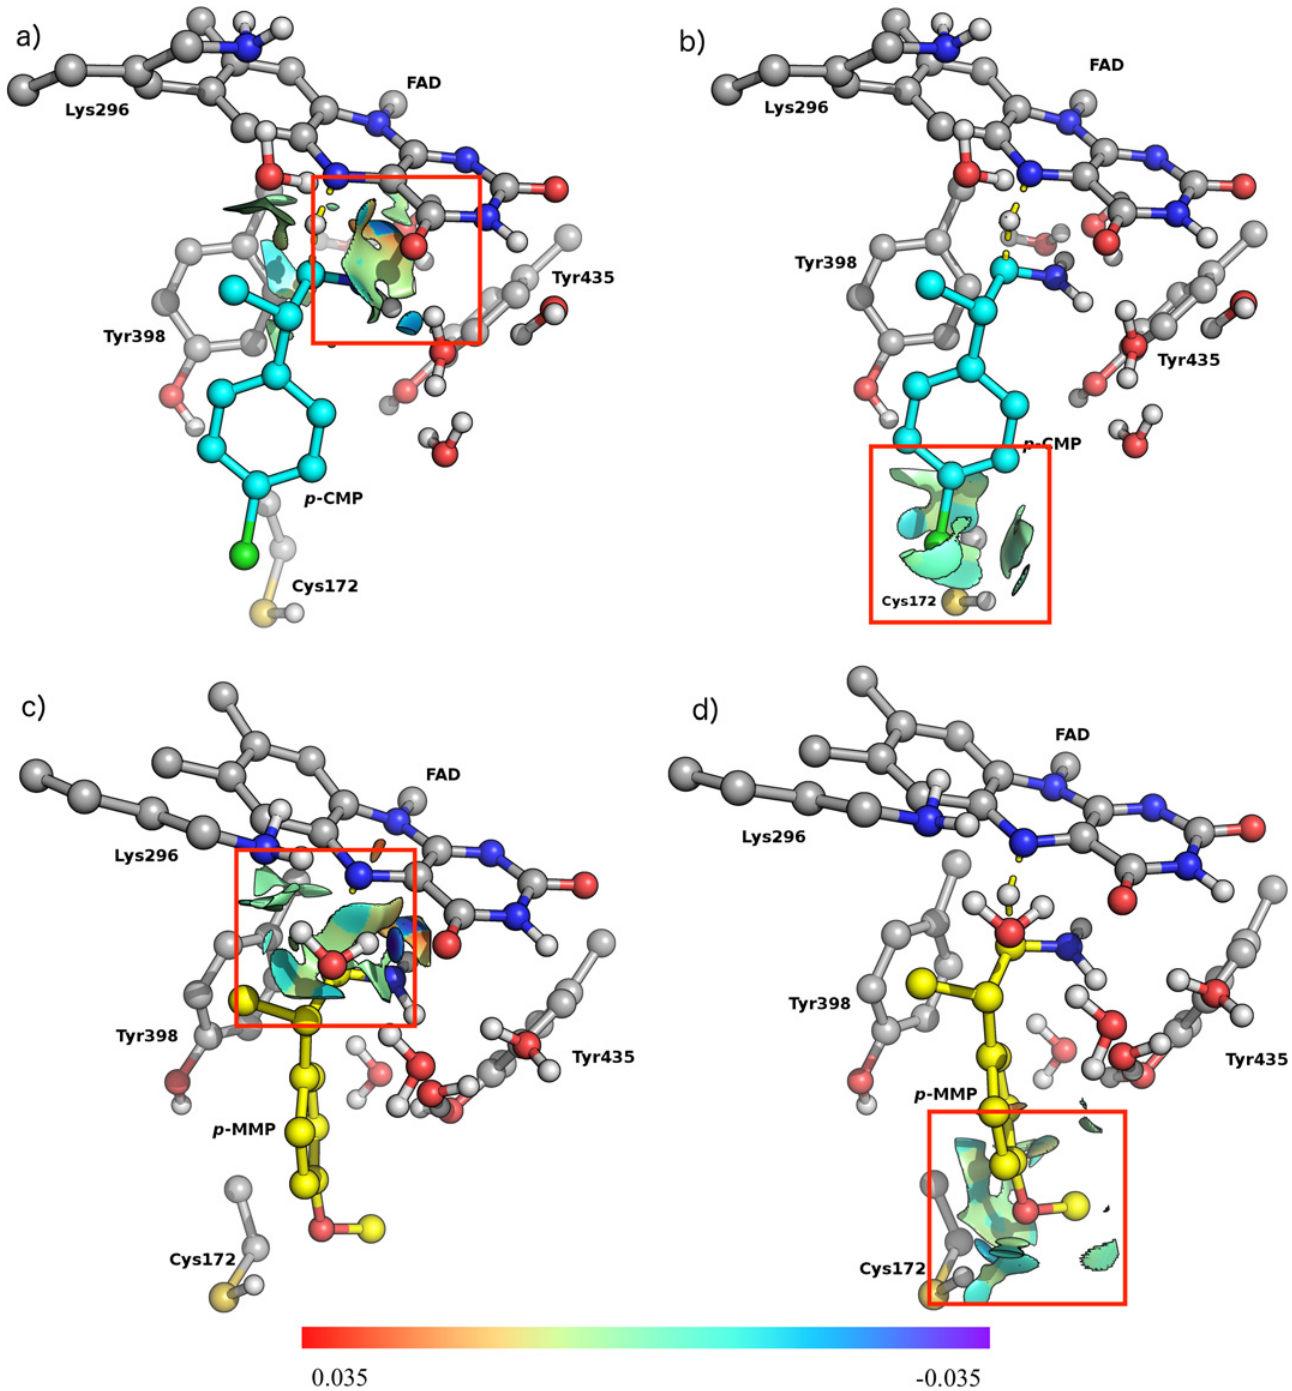
Fig 1. Non-covalent interaction (NCI) surface for binding site models in TS complexes with p-CMP and p-MMP after QM optimization. Red squares indicate hydrogen bonds (blue surfaces) and favorable van der Waals interactions (light green surfaces). a) the reactive region of p-CMP; b) p-substituent region of p-CMP, c) the reactive region of p-MMP and d) p-substituent region of p-MMP. p-CMP is depicted in cyan ball and sticks while p-MMP is depicted in yellow ball and sticks. NCI indexes isovalues range from 0.035 to -0.035 (au). p-MMP (p-methoxy- β -methylphenylethylamine); p-CMP (p-chloro- β -mehtylphenylethylamine), respectively.